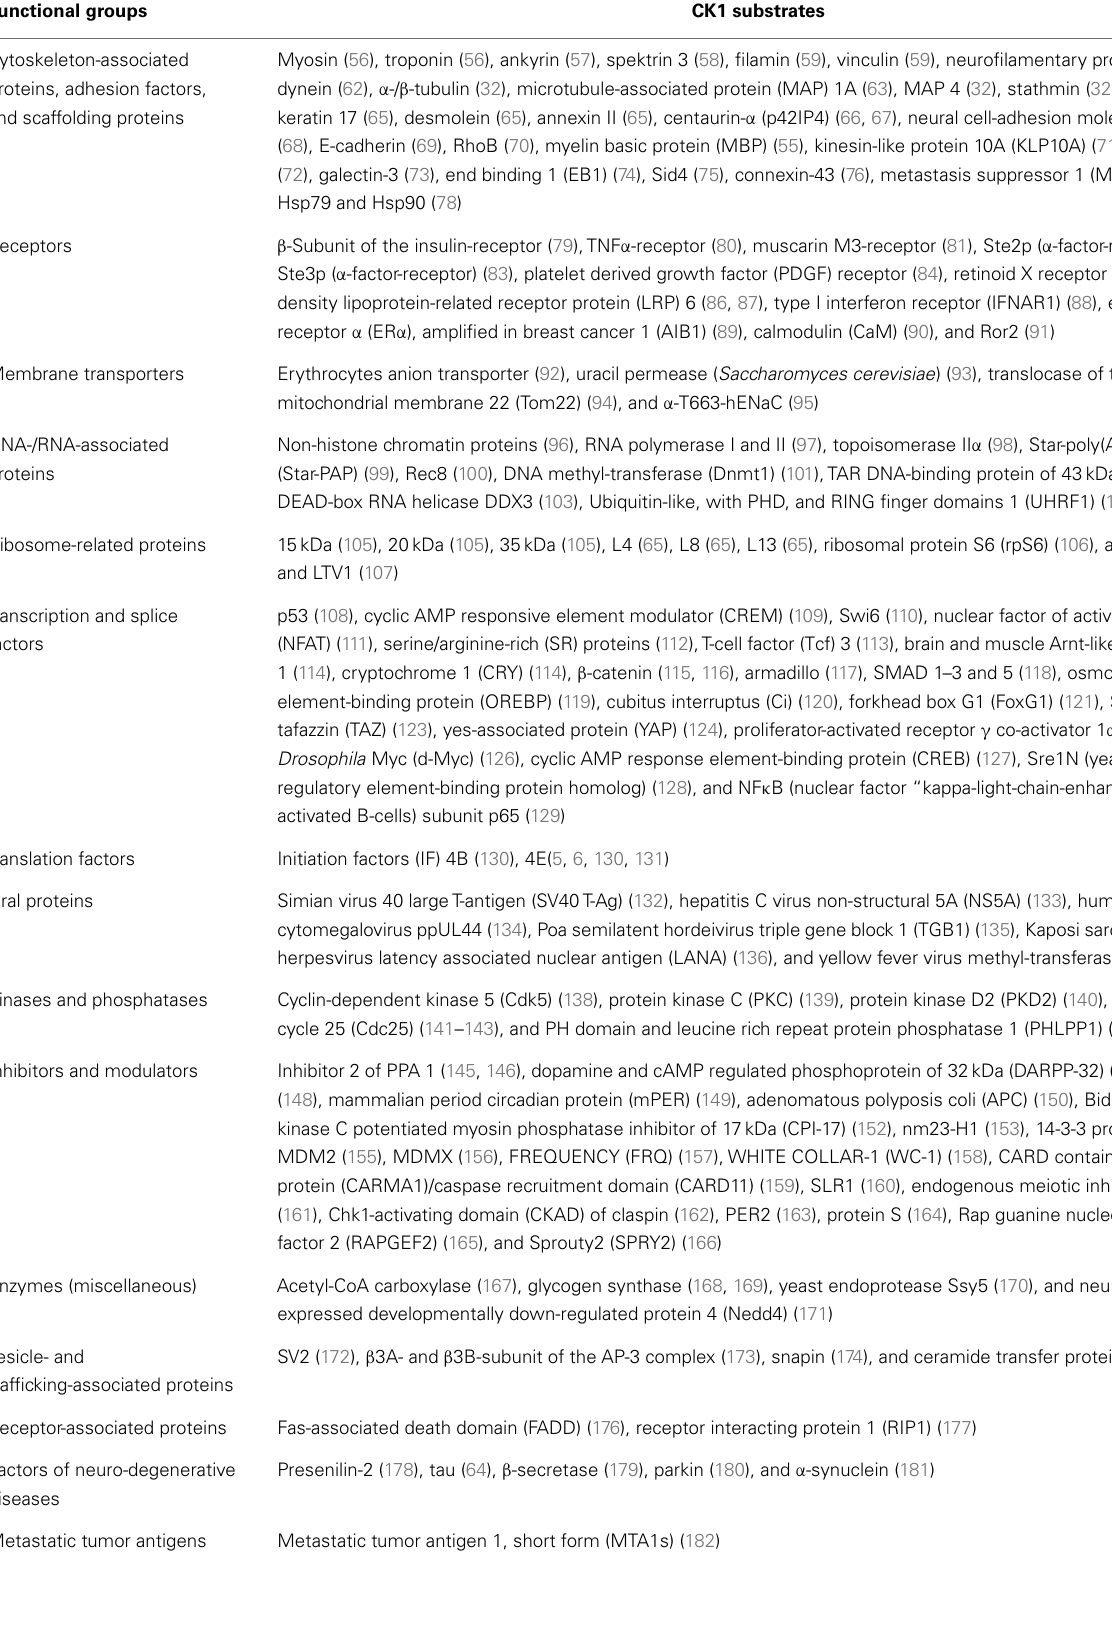
Table 1 | Reported substrates for CK1 family members and reported in vitro and in vivo substrates of CK1 family members of several species . Functional groups